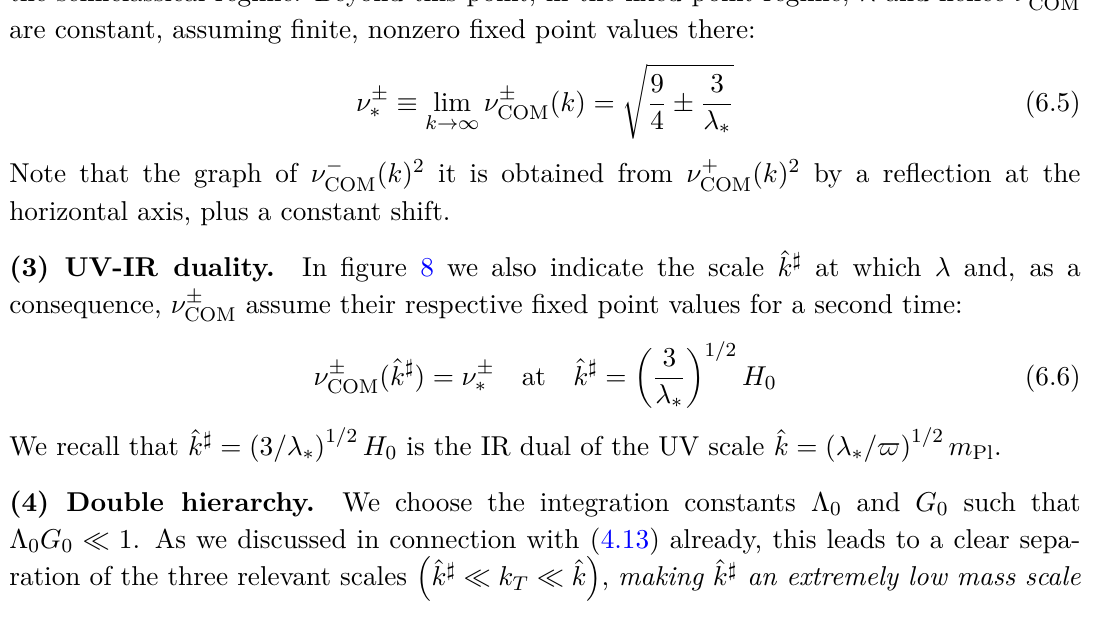
Figure 8. The functions ν + The dashed lines are their classical analogs for a scale independent